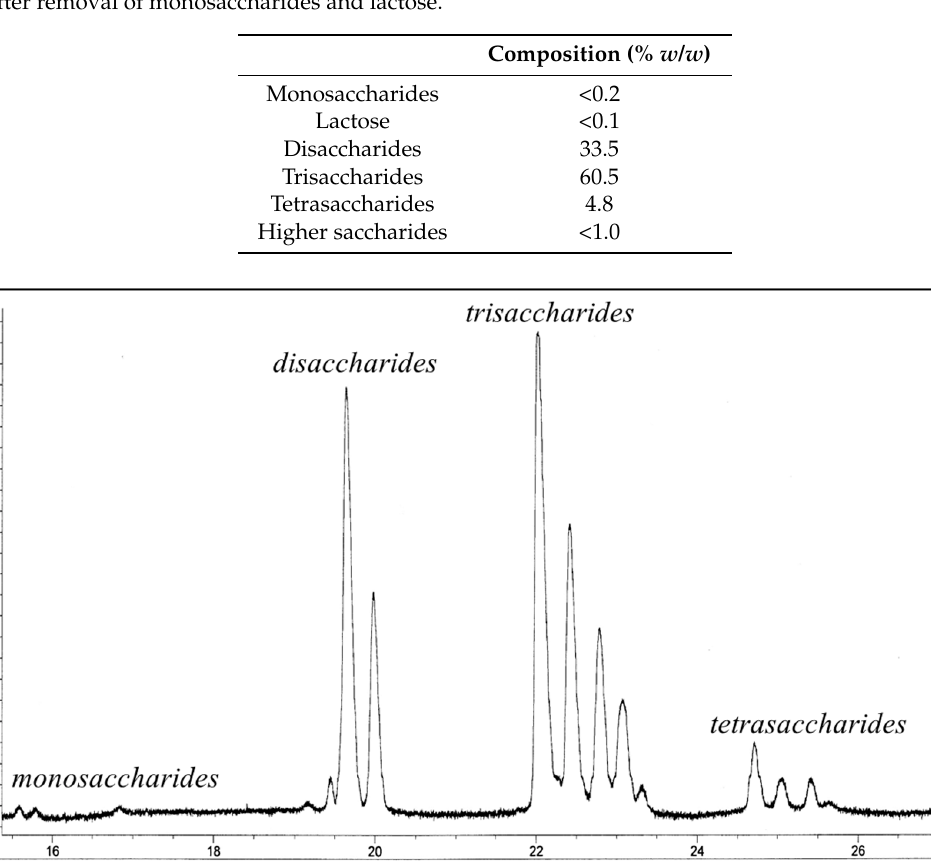
Figure 1. Separation of galacto-oligosaccharide mixture (Lb-GOS) after removal of monosaccharides and lactose using capillary electrophoresis (CE).